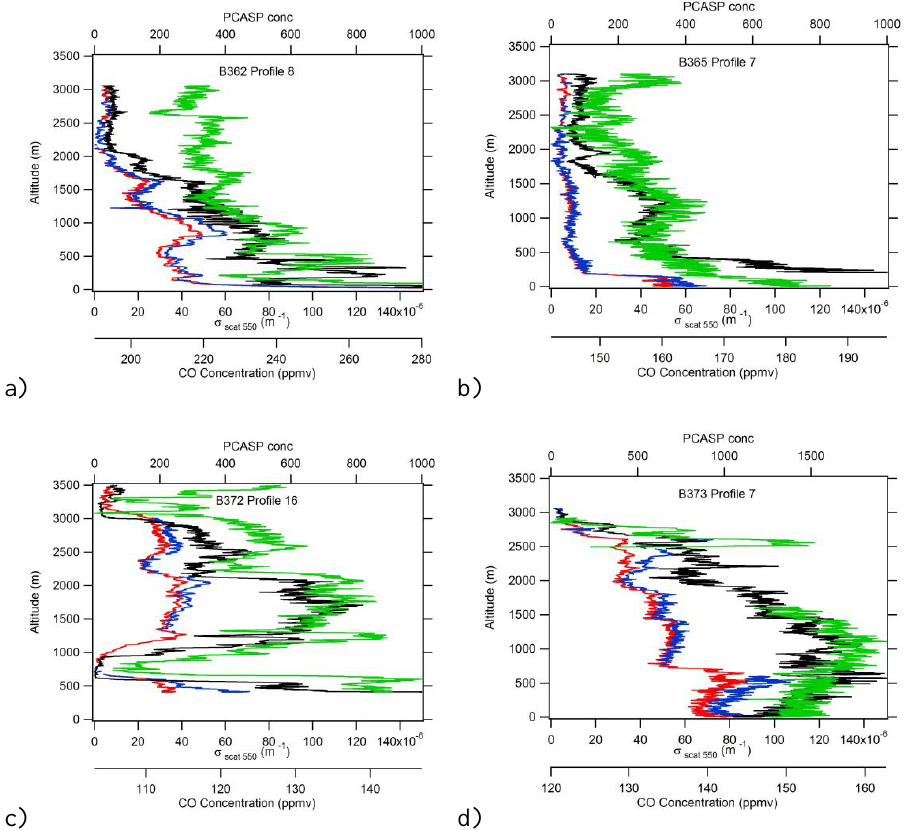
Fig. 5. Example profiles of scattering from the EUCAARI campaign. (a) Profile 8 from B362; (b) profile 7 from B365, (c) profile 16 from B372 and (d) profile 7 from B373. Dry aerosol scattering – red, scattering at ambient relative humidity – blue, PCASP number concentration in black and Carbon monoxide concentration in green. Scales for PCASP number concentration and CO concentration differ between panels.